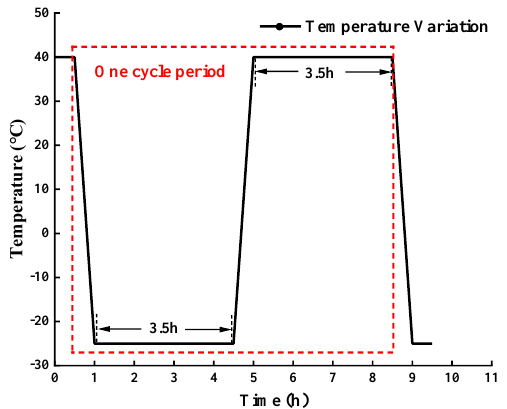
Figure 5. Schematic diagram of freeze–thaw cycle temperature variation.